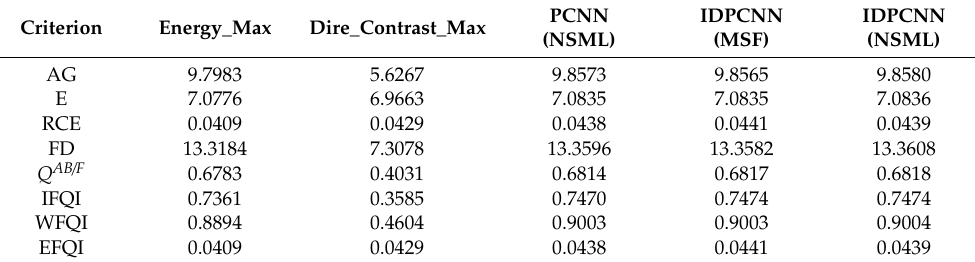
Table 4. Objective evaluation indexes of the rich terrain fused image (Data